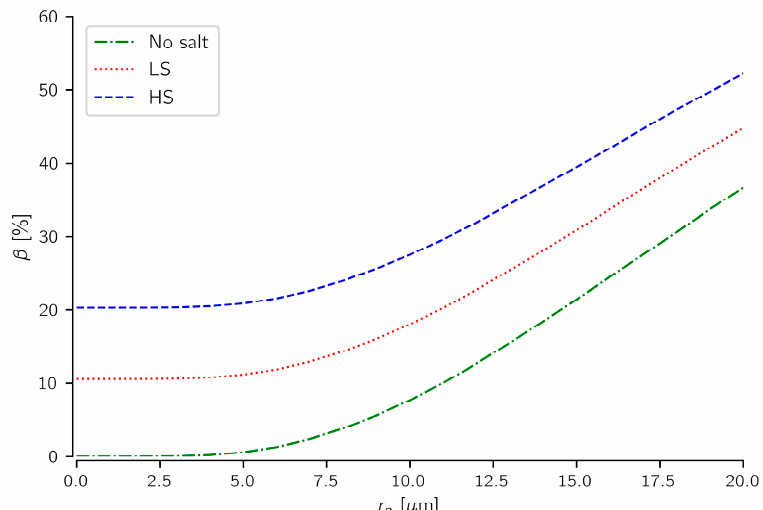
Figure 9. The coupled effect of fines mobilization and salt precipitation on CO 2 injectivity. Salt precipitation seems to compound injectivity impairment induced by fines migration. HS, high salinity brine; LS, low salinity brine.